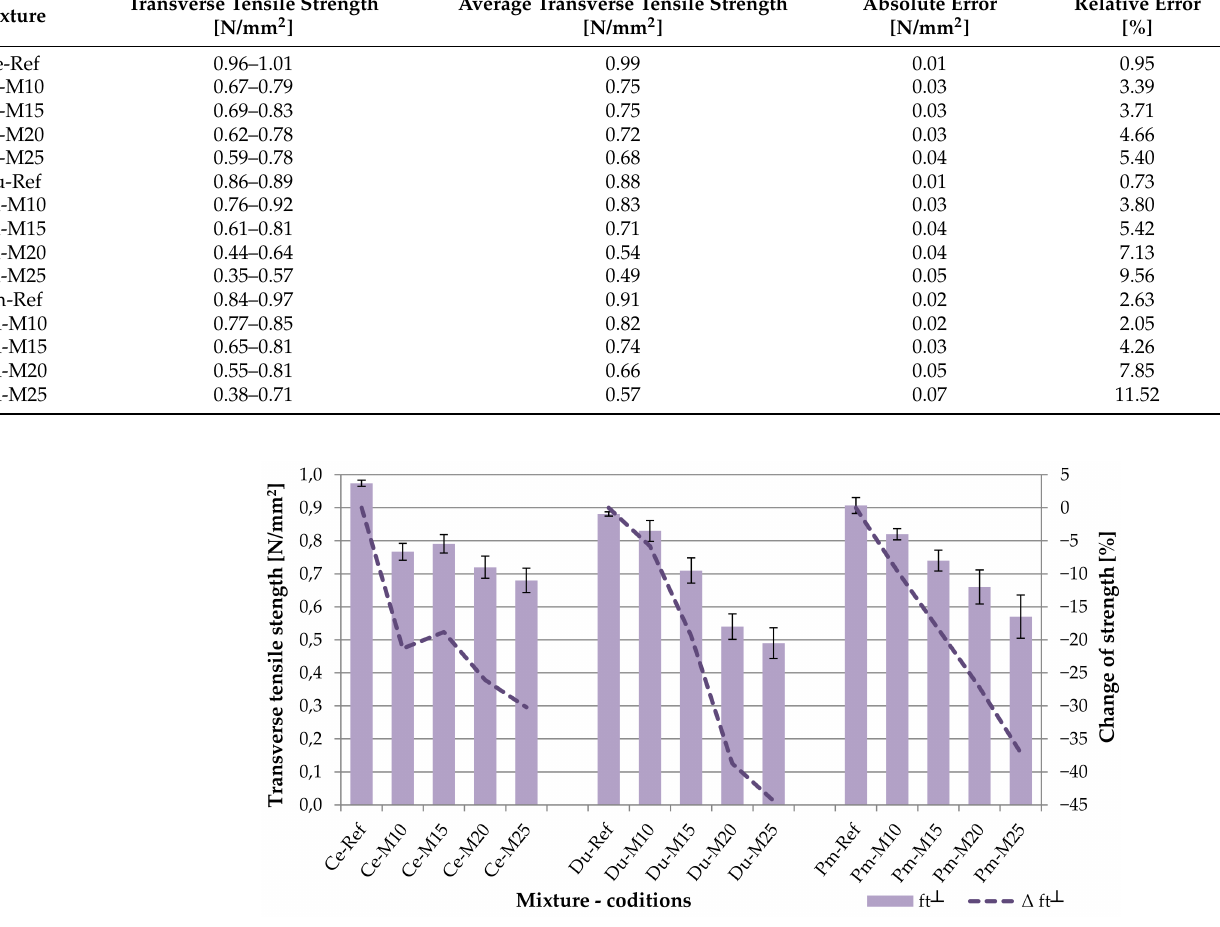
Figure 15. Comparison of transverse tensile strength perpendicular to the plane of the